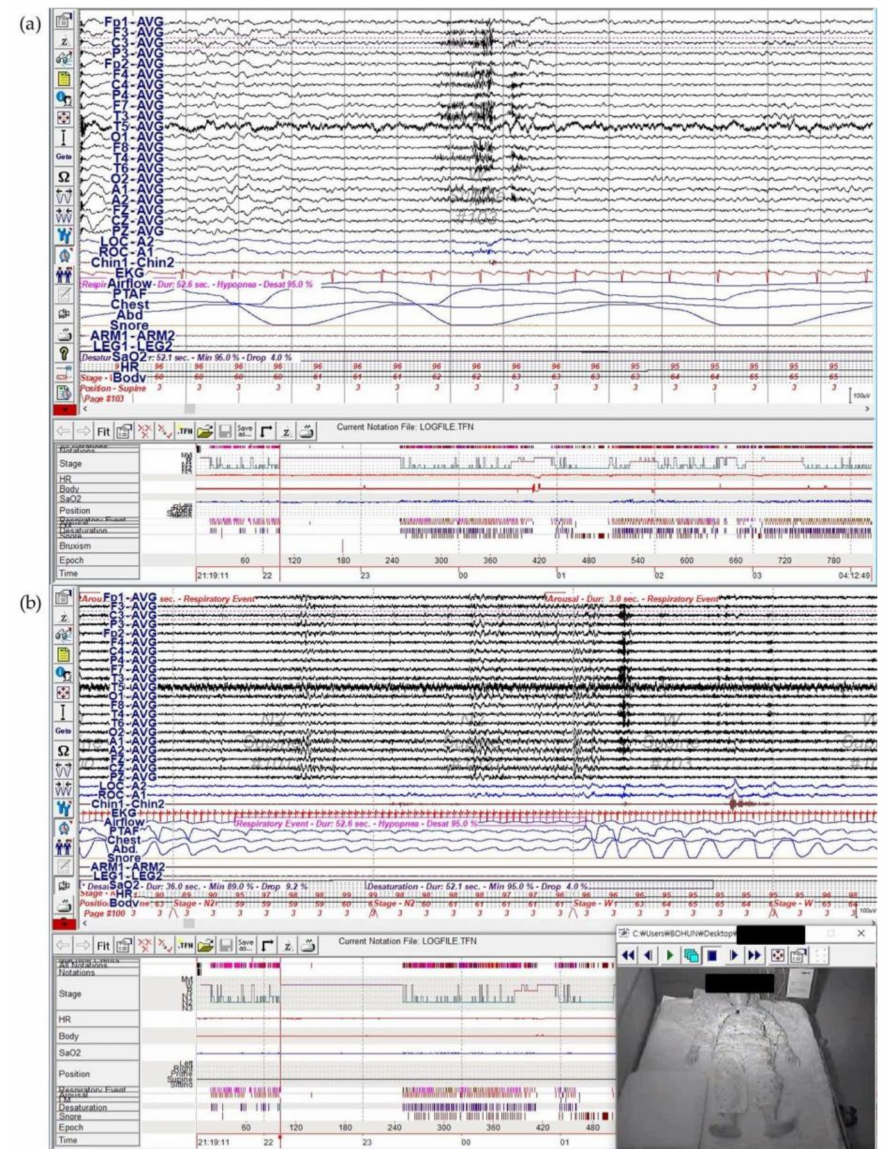
Figure 2. Nocturnal video PSG with extended EEG of the patient. Stereotypical recurrent events of awakening from sleep with numbness and indescribable odd feeling occurred in Epoch 103. ( a ) EEG channels in referential montage for 15 s, which reveals no epileptic discharge during the event. ( b ) PSG revealed obstructive hypopnea before the event. PSG: polysomnography, EEG: